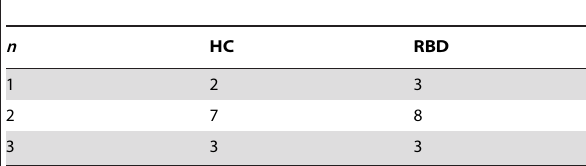
Table 3. Frequency of n (length of STM) for HCs and